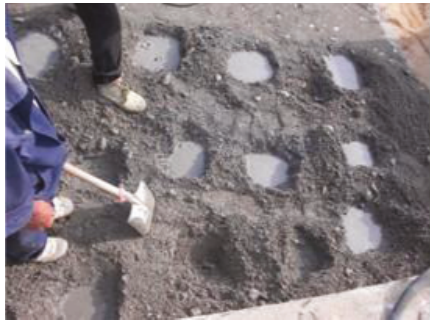
Figure 21: Grouting.